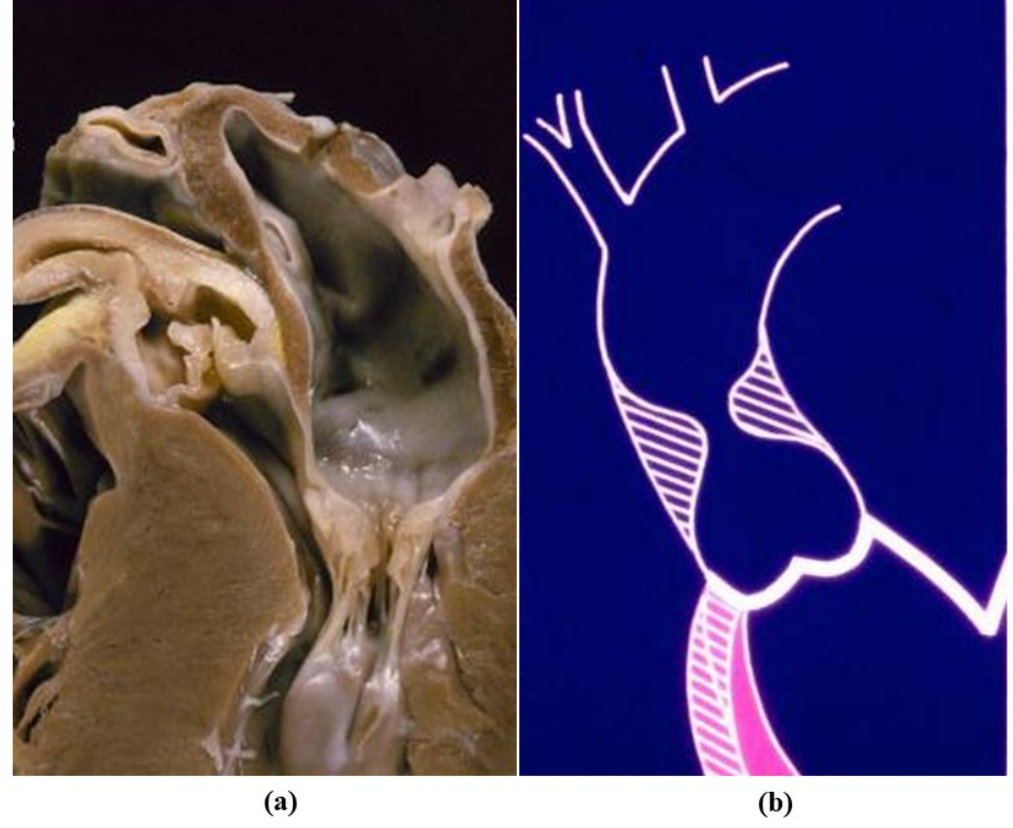
Figure 9. Long-axis ( a ) and hour-glass appearance ( b ) of supravalvular aortic stenosis in William’s syndrome.